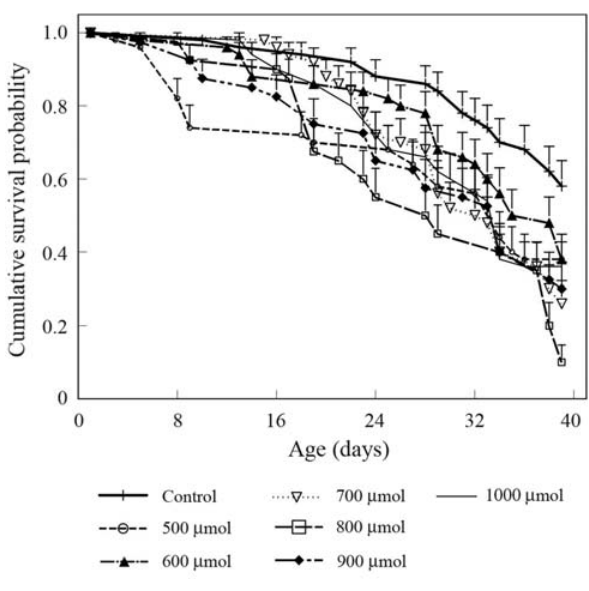
Figure 3 - Diphenyl diselenide molarities and Drosophila melanogaster adult survival curves. For each of five replicates, 30 eggs were placed on banana-agar containing different molarities of diphenyl diselenide and as- sessed for viability every day up to adulthood. Data are expressed as the cumulative survival probability.